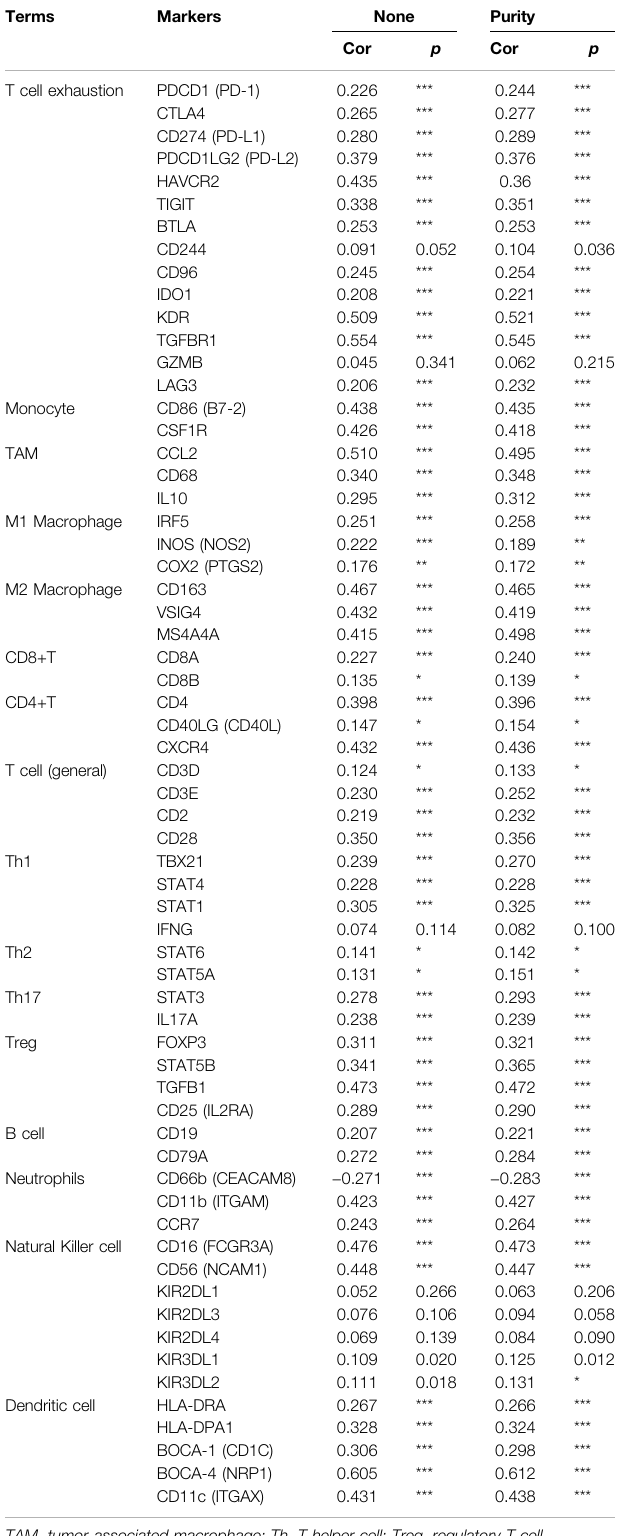
TABLE 2 | Correlation analysis between SCG2 and markers of immune